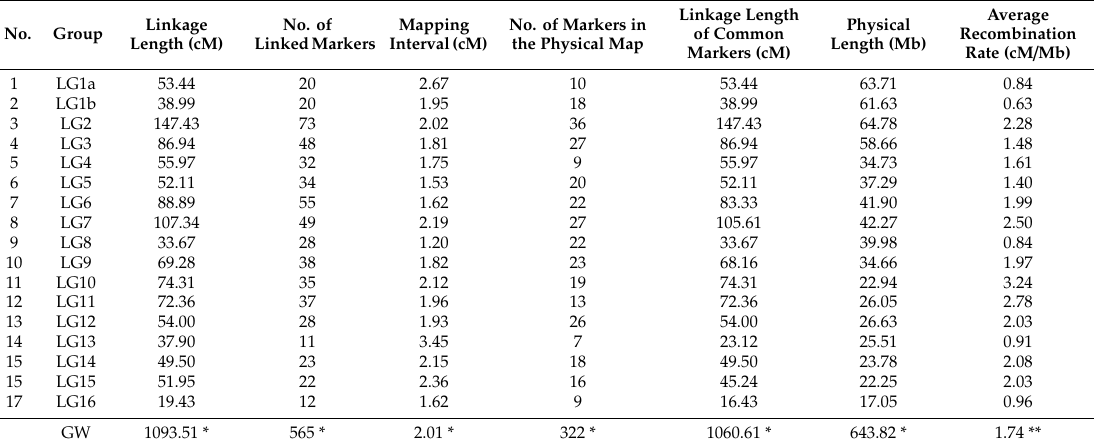
Table 2. Linkage length and mapping interval across linkage groups in the GM-3341 family. No.